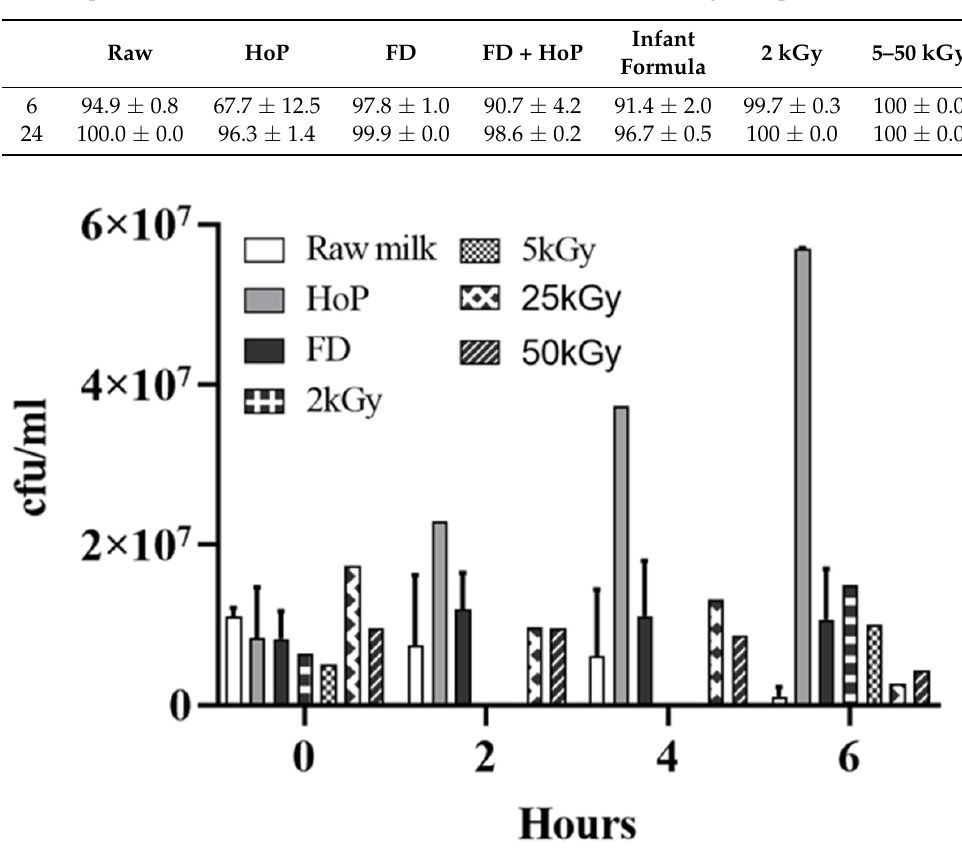
7 cfu/mL) in DHM